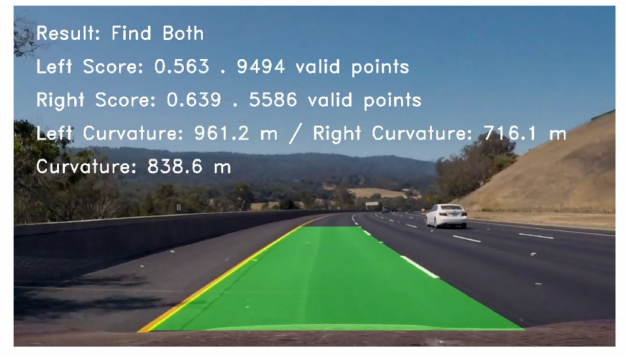
Figure 11. The lane line detection